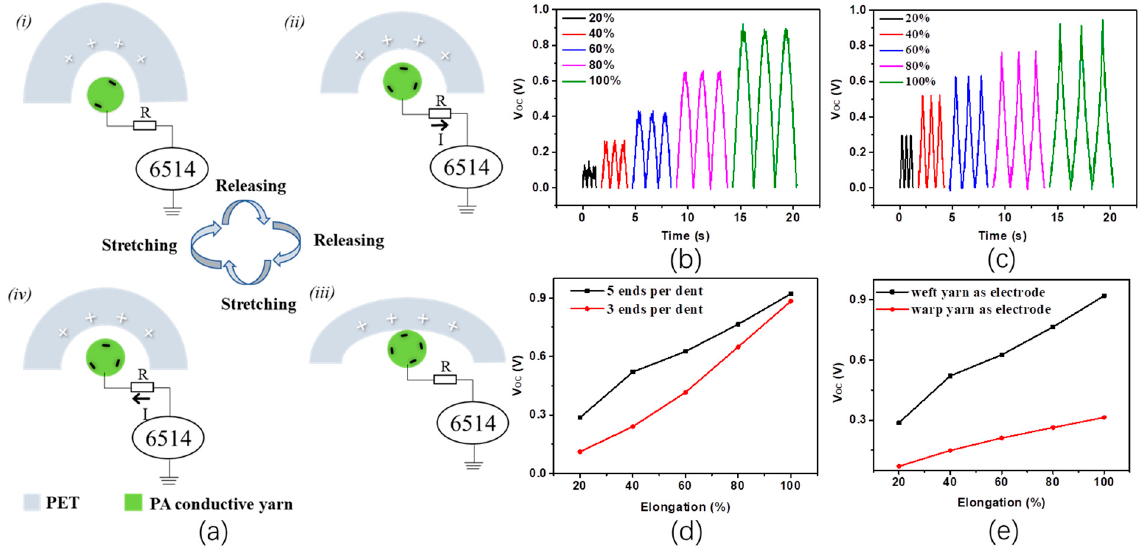
Figure 7. ( a ) The working mechanism of the 3DWE-TENG with the electrode as the weft yarn, ( i ) In the original state without stretch; ( ii ) The 3DWE-TENG is gradually stretched; ( iii ) The 3DWE-TENG is stretched to the largest deformation; ( iv ) The 3DWE-TENG is gradually recovering to the original state; ( b ) The V OC of 3DWE-TENG with a warp yarn density of 417 ends/10 cm in a stretch state; ( c ) The V OC of 3DWE-TENG with a warp yarn density of 533 ends/10 cm in a stretch state; ( d ) The V OC comparison of two 3DWE-TENGs with different warp yarn densities, including five ends per dent and three ends per dent; ( e ) The V OC comparison of two 3DWE-TENGs with the weft yarn and the warp yarn as the electrode, respectively.